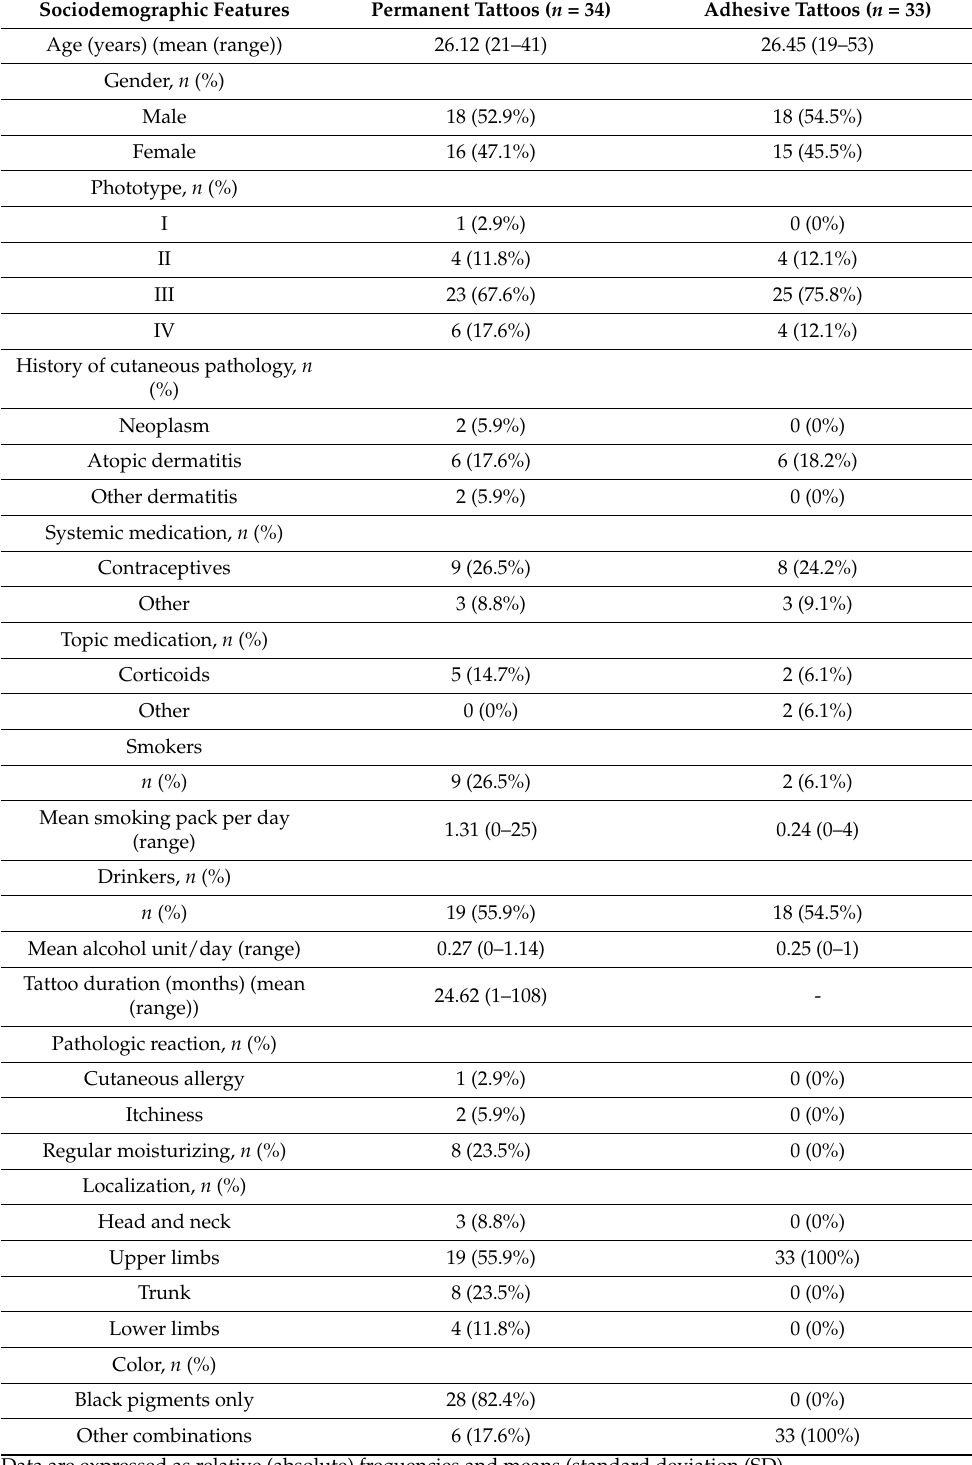
Table 1. Descriptive characteristics of permanent and adhesive tattoos and the subjects they belong to. Sociodemographic